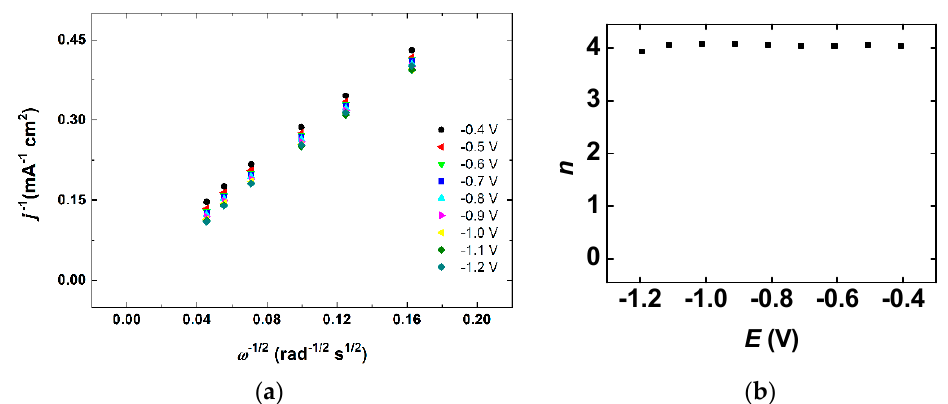
Figure 6. Koutecky-Levich plots derived from the experimental data shown in Figure 4d (GC elec- trodes modified with wood-based, nitrogen-doped activated carbon synthesized at 800 ° C, AC-800- N) ( a ). The potential dependence of n ( number of transferred electrons per O 2 molecule) ( b ).